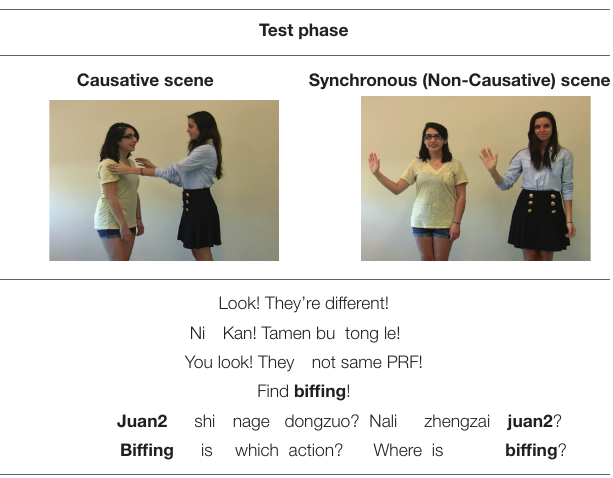
TABLE 2 | Example of a test phase viewed by English participants in Experiments 1a, 1b (“VP Modifier” condition) and Mandarin participants in Experiments 2a, 2b.